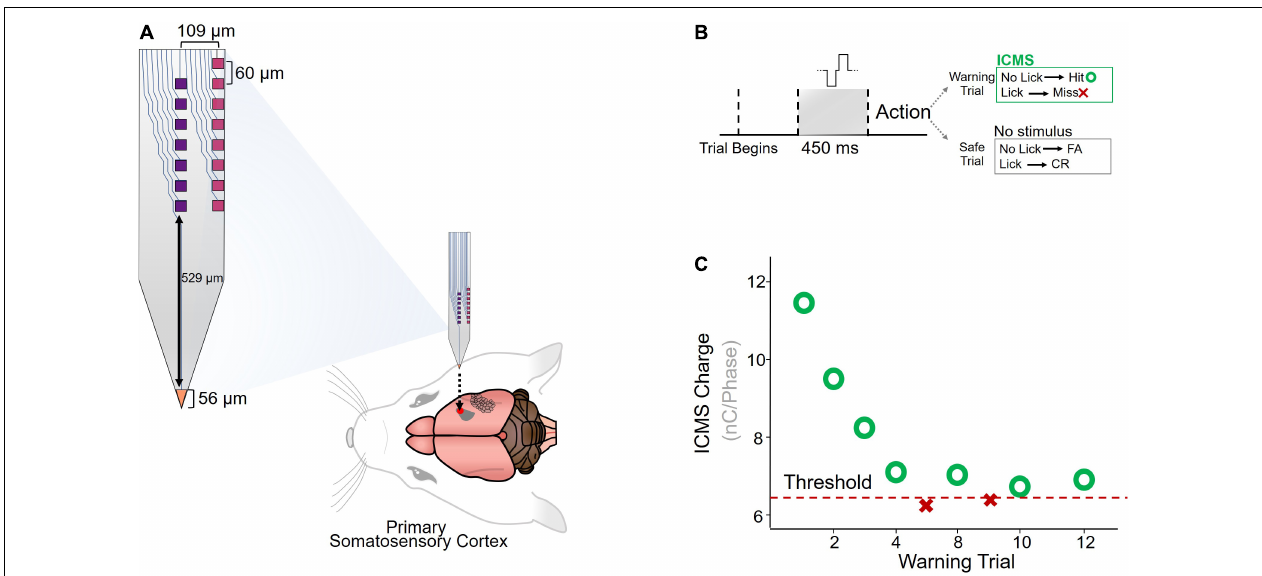
FIGURE 1 | Implantation and behavioral paradigm. (A) Diagram of custom-made planar silicon microelectrode array (Lee et al., 2017), implanted in the primary somatosensory cortex of Sprague-Dawley rats ( N = 6). (B) A conditioned-avoidance behavioral paradigm was used to measure ICMS detection thresholds. Rats were trained to briefly stop drinking after an ICMS stimulus was detected, and failure to stop drinking resulted in a small shock applied through the drinking spout. (C) Adaptation protocol for determining detection